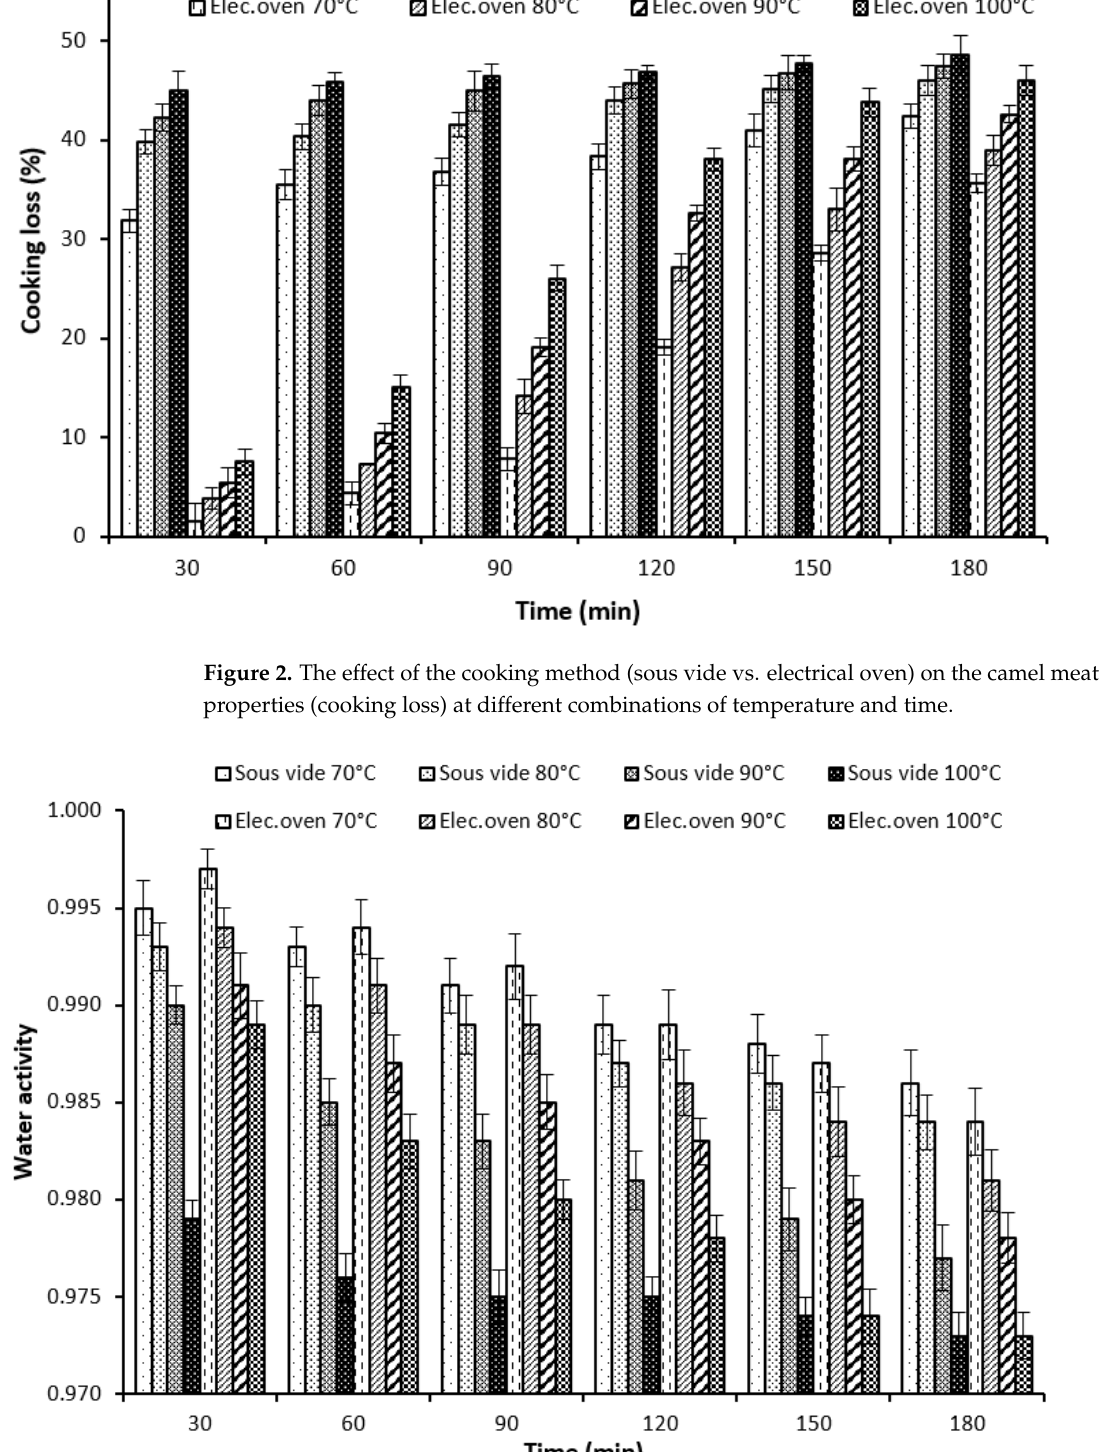
Figure 3. The effect of the cooking method (sous vide vs. electrical oven) on the camel meat physical properties (water activity) at different combinations of temperature and time .